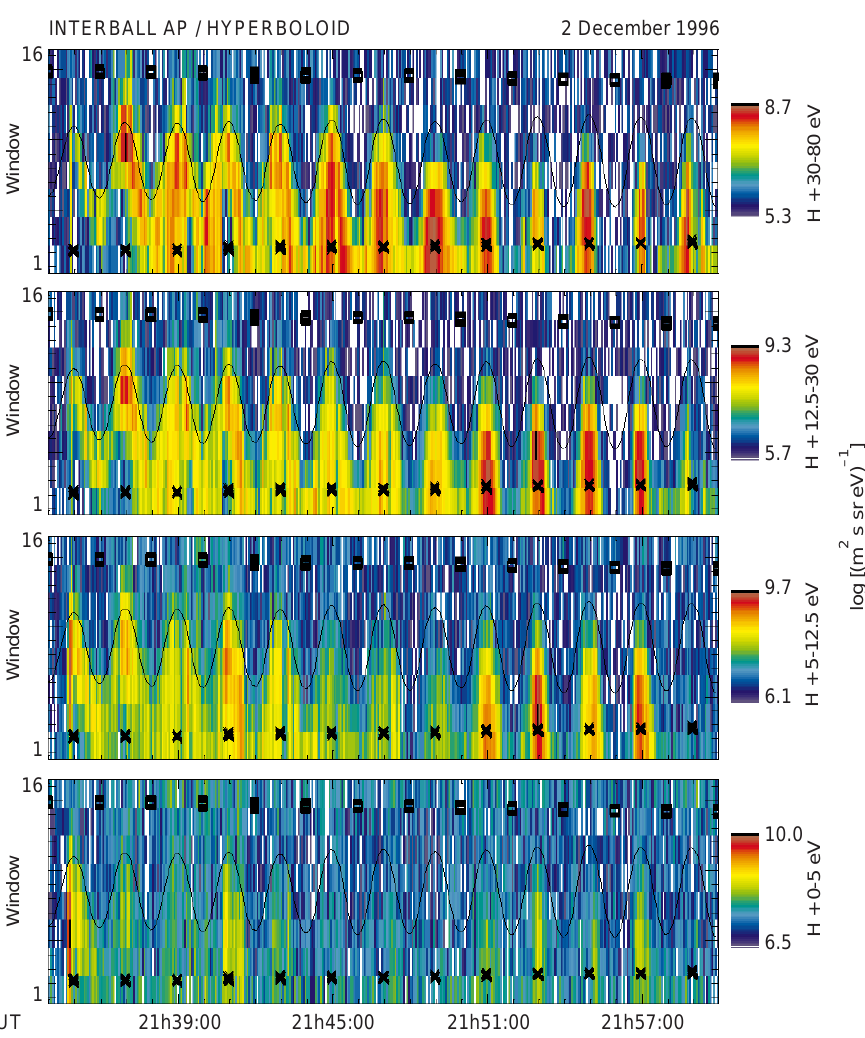
Fig. 6. Evolution of the H + distribu- tion function on 2 December